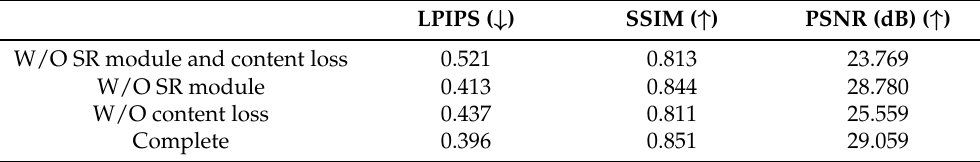
Table 5. Quantitative ablation study of Ours(b) network for the SR module and content